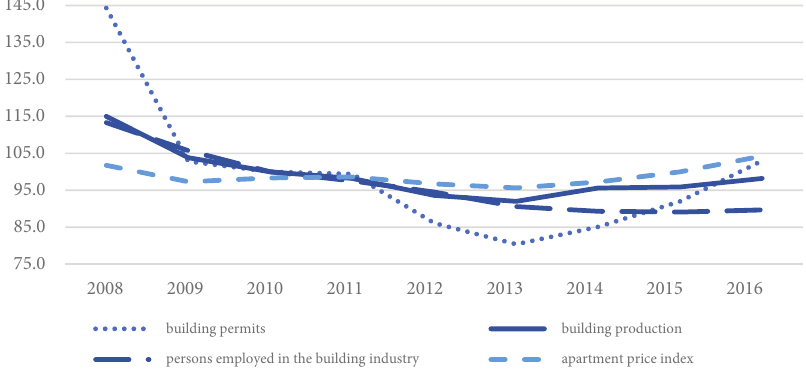
Figure 1. Formation of time series in the examined dimensions (average values for 28 European states) (source: author’s own study)